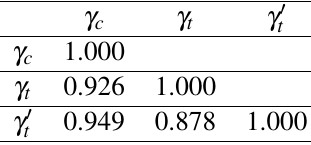
Table 3 contains the correlation of domination parameters with physicochemical properties of octane